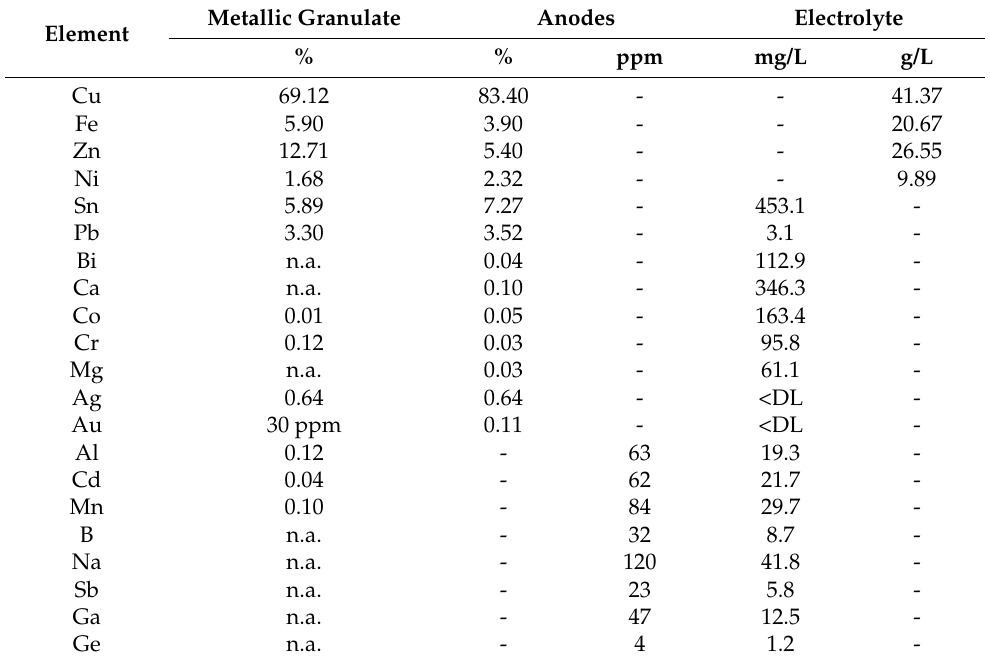
Table 1. Chemical composition of pyro-electro and solvent extraction feed (n.a., not analyzed; <DL, below detection